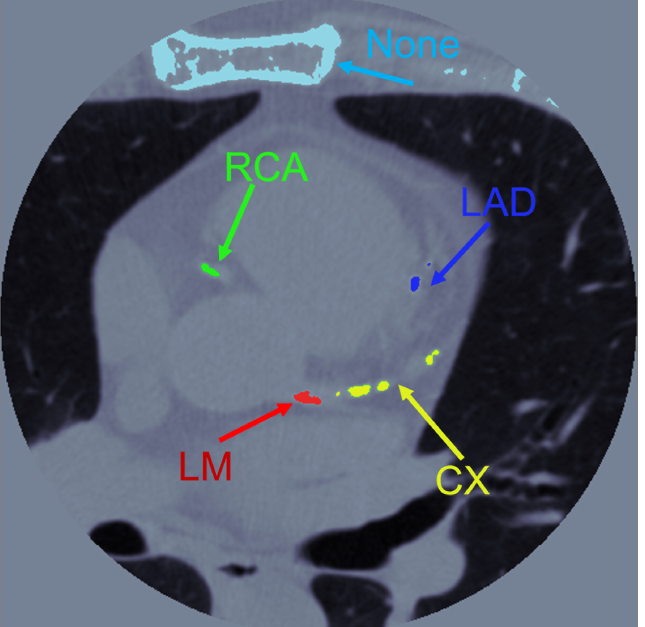
Figure 1. Stages of web application development.